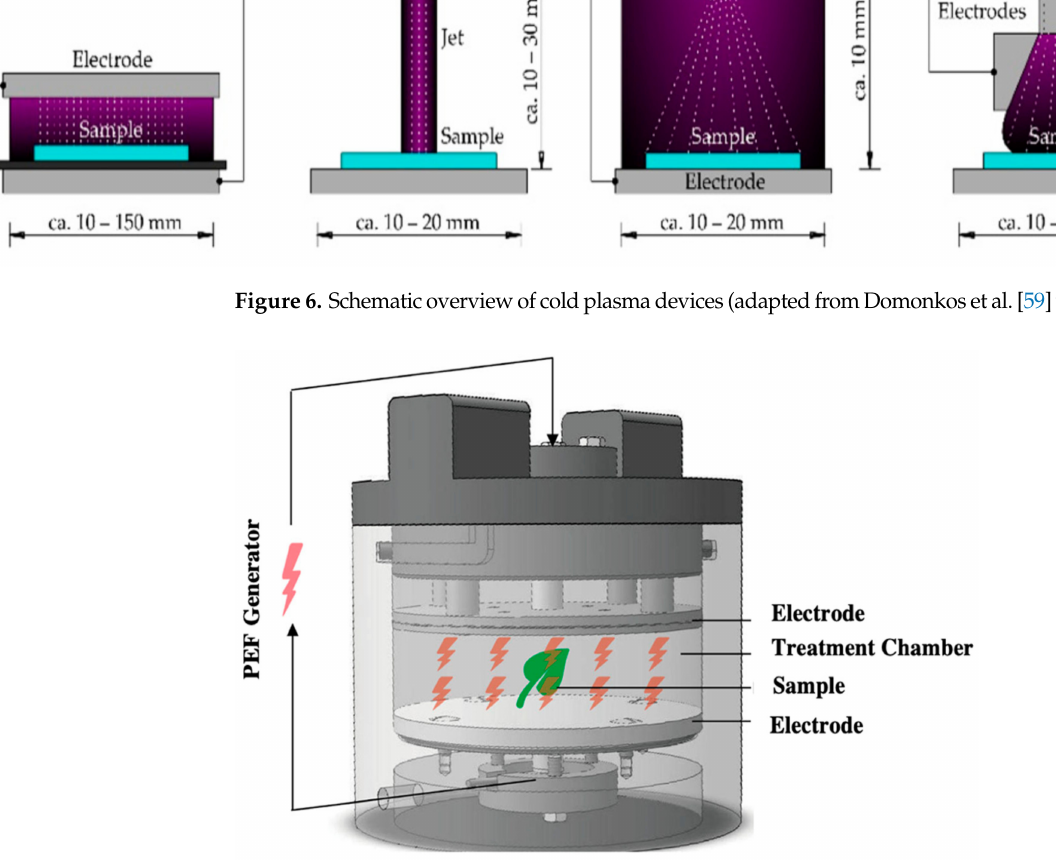
Figure 7. Schematic diagram of a typical PEF chamber (reproduced from Liu et al. [74] with